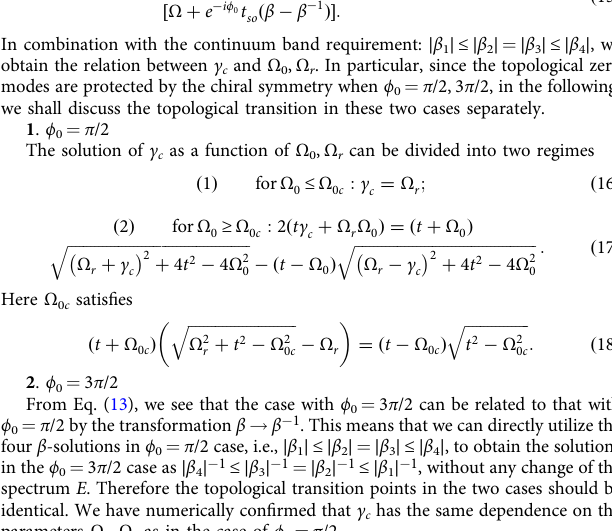
t 2 (cid:2) Ω 2 0 c